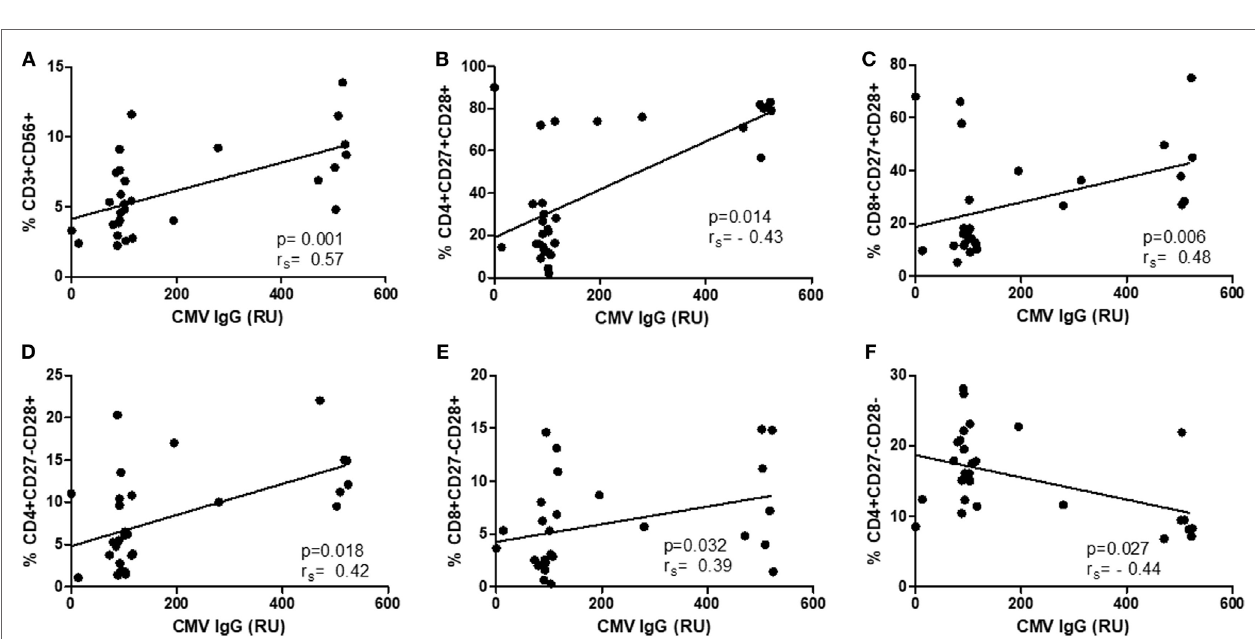
FigUre 4 | Correlation between IgG anti-cytomegalovirus (CMV) titers and immunosenescence markers in women with breast cancer. (a–D) Show the correlations between senescent CD4 and CD8 T cell ( r s = 0.71, p < 0.0001; r s = 0.44, p = 0.04) and natural killer and NKT ( r s = 0.51, p = < 0.02; r s = 56, p = 0.007) and anti-CMV